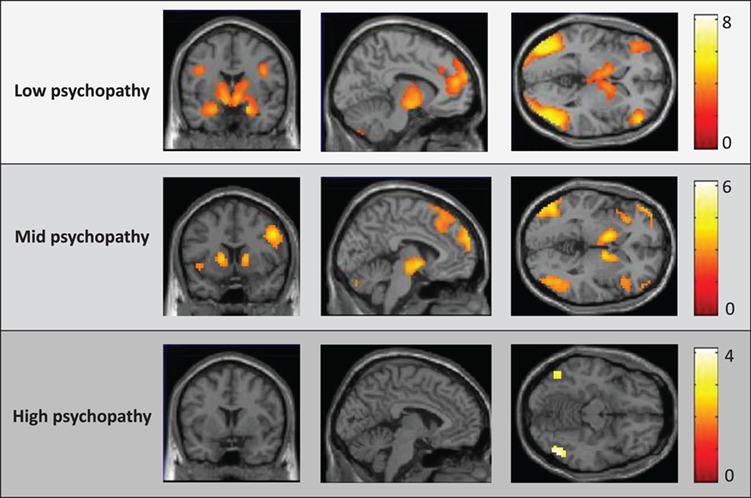
Neural activity within the NegWATCH > NeutWATCH contrast for each of the low-, mid- and high-psychopathy groups. SPM thresholded at \documentclass[12pt]{minimal}
\usepackage{amsmath}
\usepackage{wasysym} 
\usepackage{amsfonts} 
\usepackage{amssymb} 
\usepackage{amsbsy}
\usepackage{upgreek}
\usepackage{mathrsfs}
\setlength{\oddsidemargin}{-69pt}
\begin{document}
}{}$P < 0.005$\end{document}, uncorr. for display purposes.